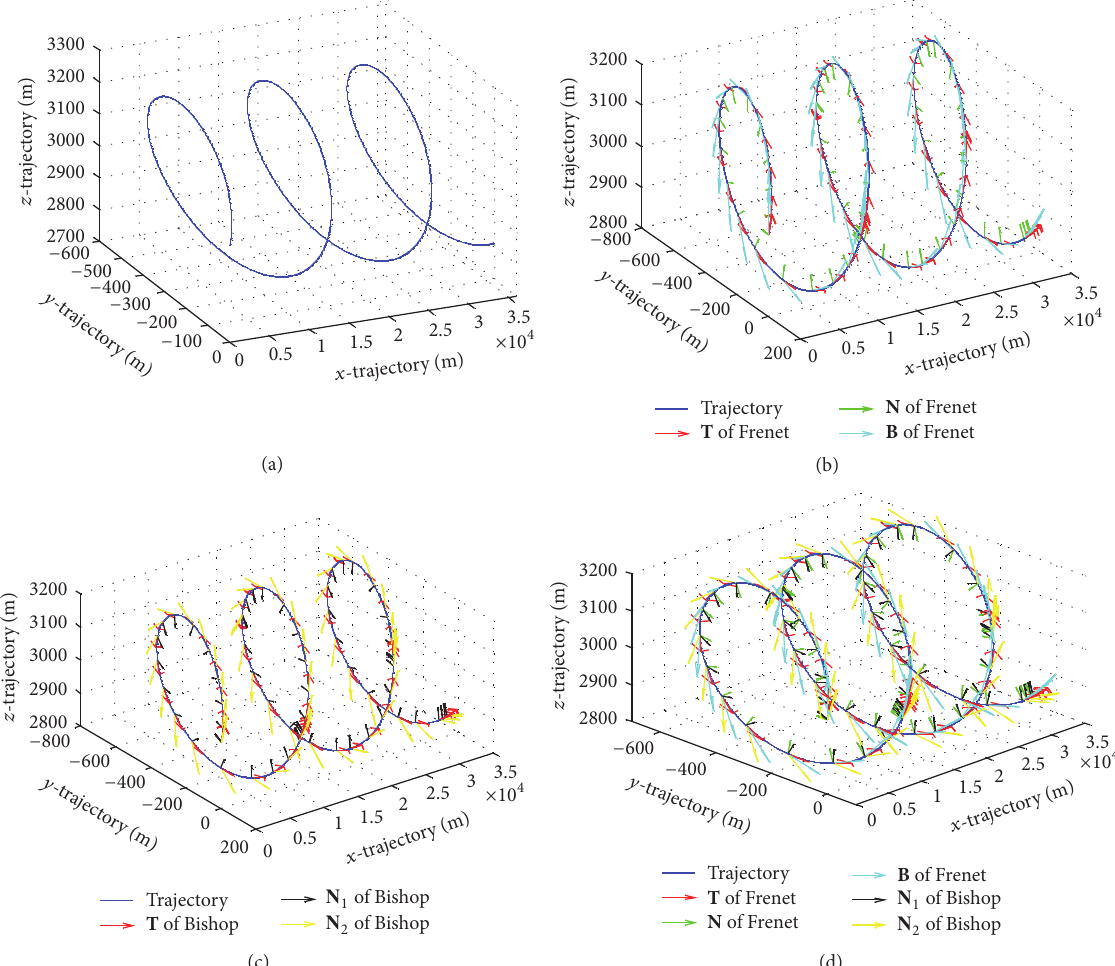
Figure 4: (a) Trajectory of target curve, (b) the target curve and its Frenet frame, (c) the target curve and its Bishop frame, and (d) the target curve and its moving